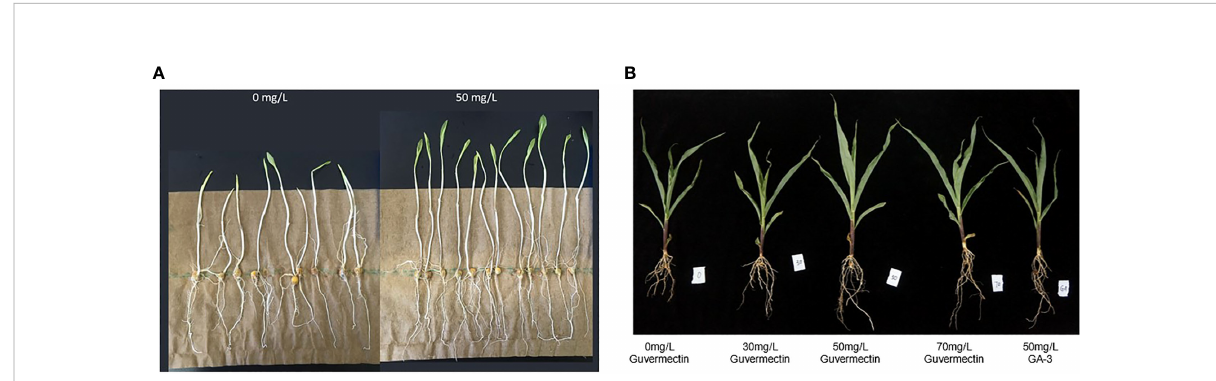
FIGURE 1 The effect of exogenously applied guvermectin on the maize seedling growth. (A) Maize seedling growth after guvermectin treatment in paper roll culture system at 14 days. (B) Maize shoot length after guvermectin treatment at 4, 7, 14 days. The experiments were conducted with three biologically independent replicates experiments, per N>24 seedlings per